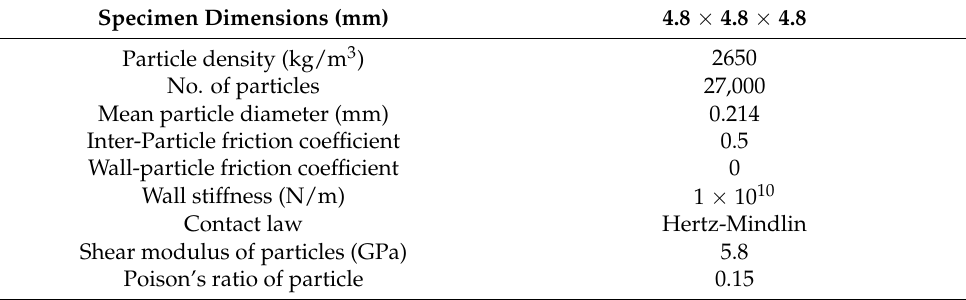
Figure 2. Particle size distribution in DEM simulation. Table 1. Parameters in the DEM